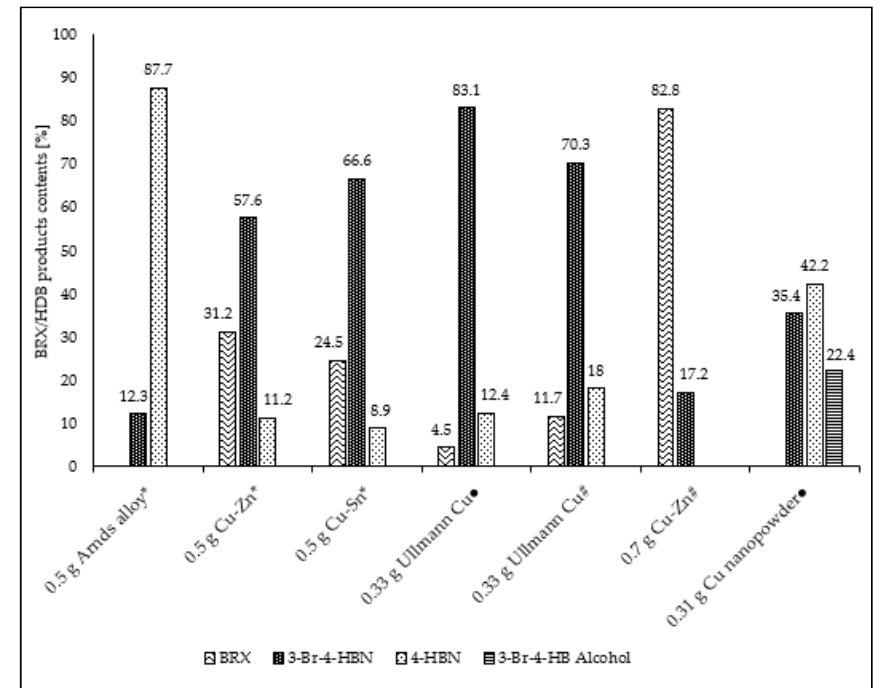
Figure 8. Effect of different sources of the Cu-catalysts on the HDB of BRX using NaBH 4 after 18 h. HDB agents were added to the solution containing 0.5 mmol BRX + 10 mmol NaOH in 100 mL H 2 O + 5 mmol NaBH 4 (*) or 0.5 mmol BRX + 2 mmol NaOH in 100 mL H 2 O + 21 mmol NaBH 4 ( ● ); or 0.5 mmol BRX in 100 mL MeOH + 21 mmol NaBH 4 (#).